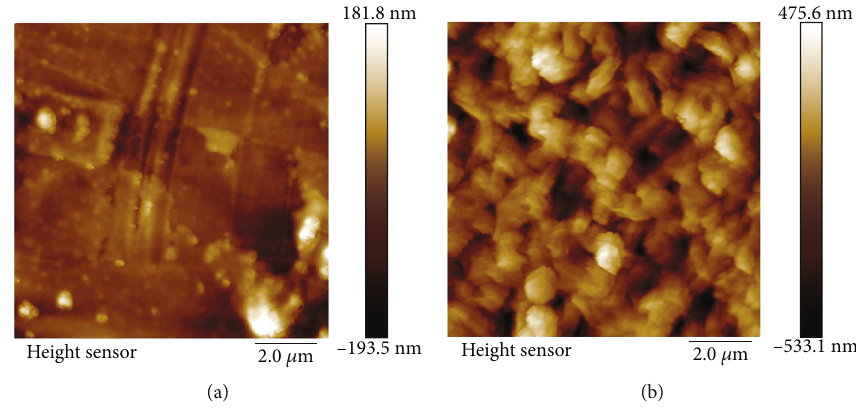
Figure 7: AFM images of (a) PEG membrane and (b) PEG/MYNS MMM.